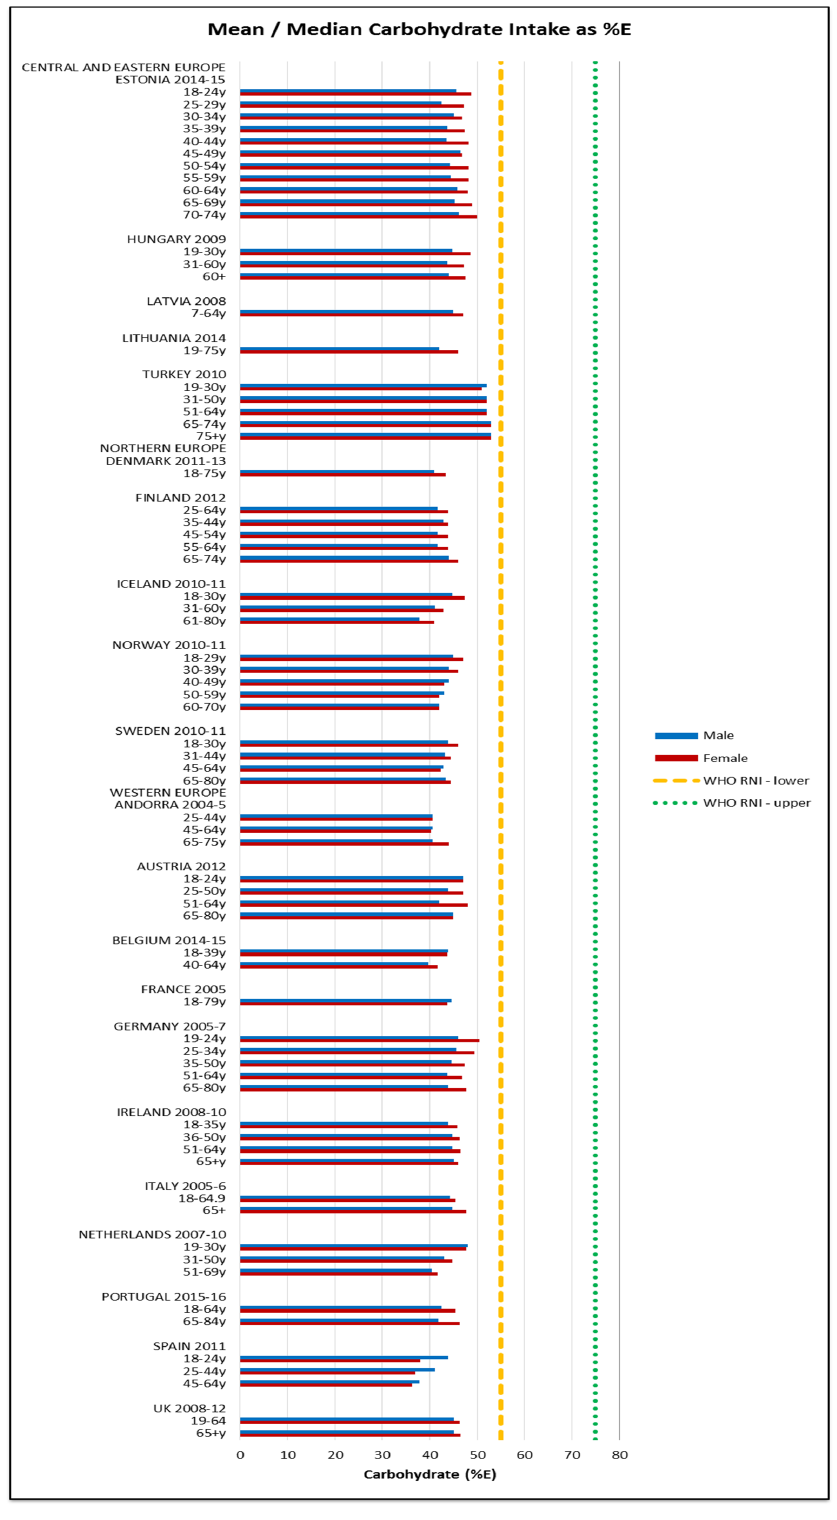
Figure 4. Mean/median* adult carbohydrate intake (g/day) (excluding supplements). * Figures for Spain are based on median rather than mean values.